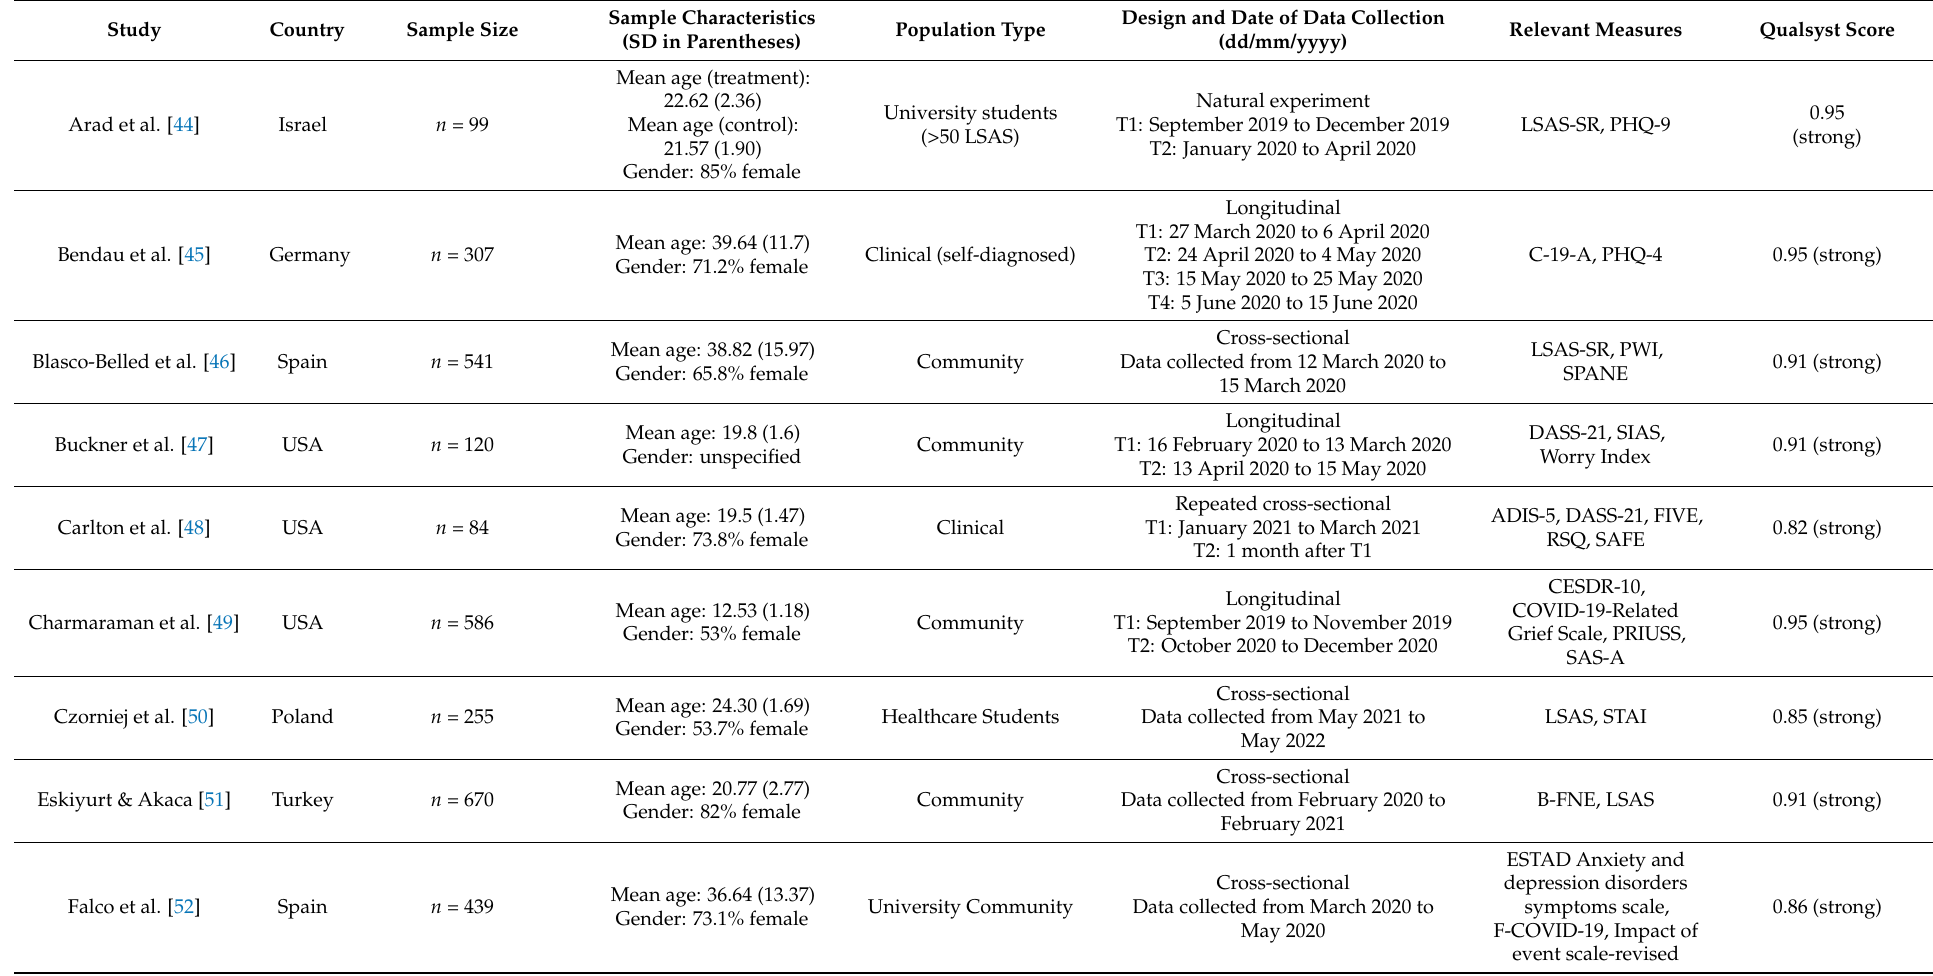
Table 1. Characteristics of Included